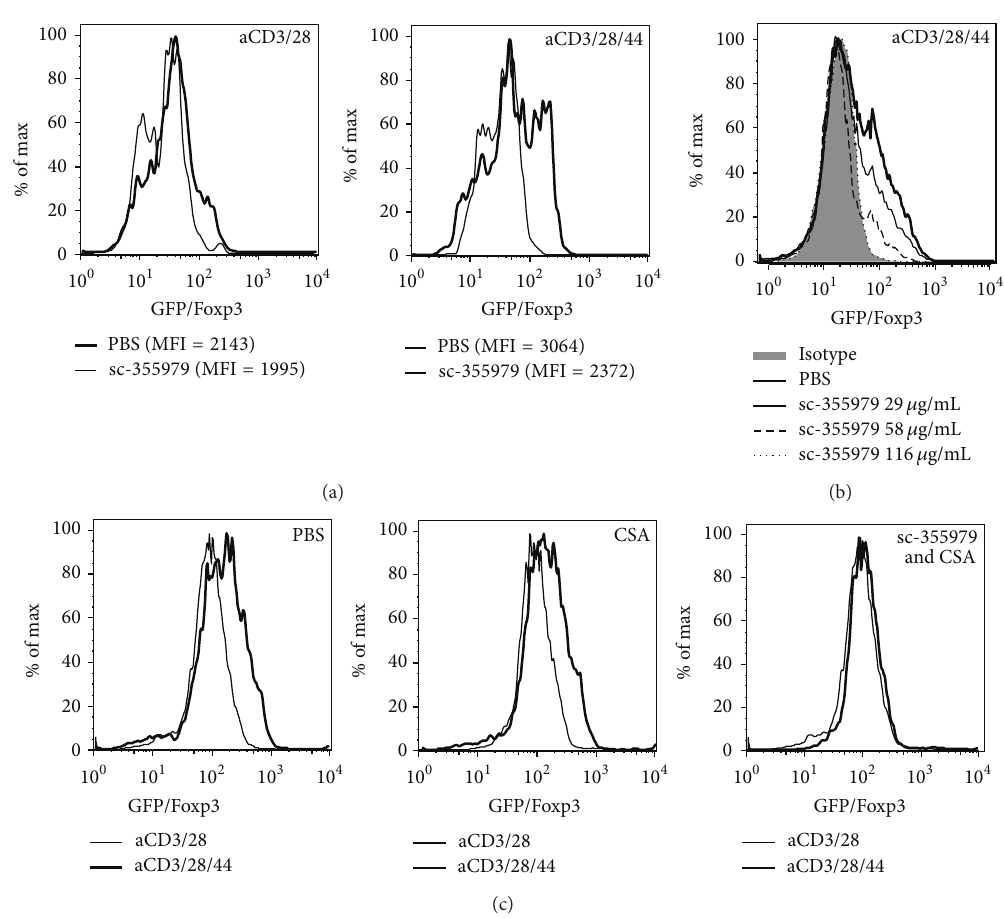
Figure5: CD44-mediatedFoxp3expressionisStat5-dependent .(a)RepresentativehistogramsforGFP/Foxp3expressionofCD4+GFP/Foxp3+ Tregfollowingcultureinthepresenceofsc-35597,aselectivepStat5inhibitor.(b)RepresentativehistogramsforGFP/Foxp3following3daysof culture with aCD3/28/44 together with increasing concentrations of sc-35597. (c) Representative histograms depicting GFP/Foxp3 persistence following culture with CSA (50ng/mL) alone or in conjunction with sc-35597. Data for (a–c) are representative of at least 3